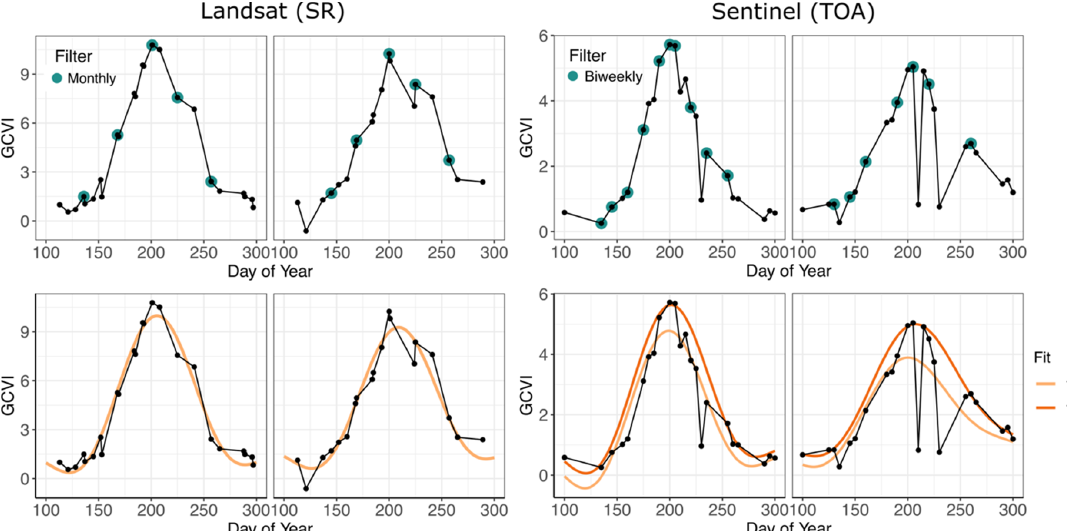
Figure 2. Satellite Processing Methods. Illustration of data processing for two pixels in 2018. Top Row: to create a standardized data set, we selected the satellite image with the highest vegetation index (VI) in each monthly (Landsat) or biweekly (Sentinel-2) period during the growing season. Bottom Row: harmonic fits applied to the cloud-masked time series. The black points show all observations before filtering. We used the first fit for Landsat and 10th recursive fit for Sentinel-2, due to residual noisiness from its less reliable cloud mask (see Methods). SR = surface reflectance; TOA = top of atmosphere; GCVI = Green Chlorophyll Vegetation Index.